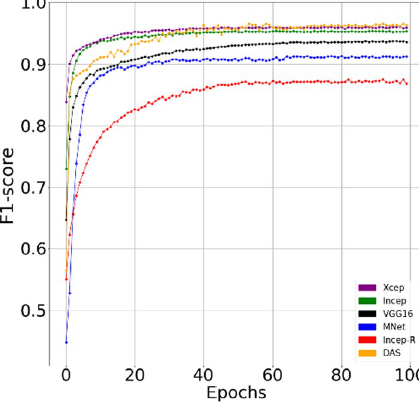
Fig. 10 Evolution of the F1-score during training of each model in the Oil Spill dataset. Each curve represents the average of the F1-score along the 50 experiments